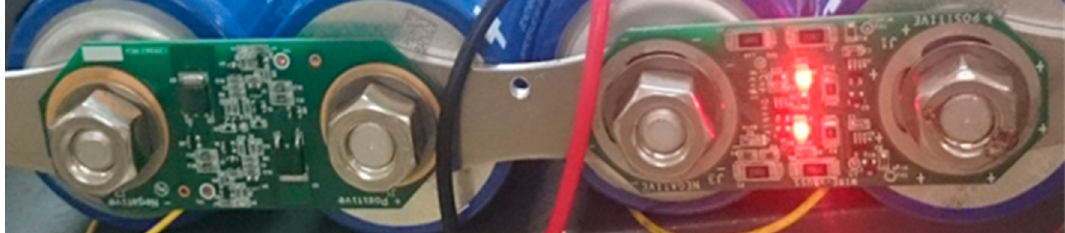
Figure 10. Four SCs connected in series with the active balance board in “standby mode” (left one) and in “on mode” (right one).